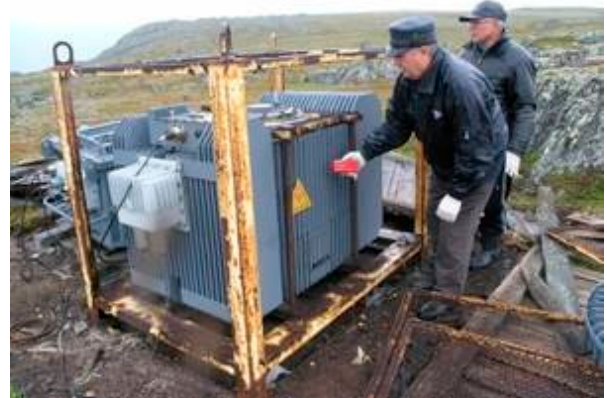
Figure 6. Radioisotope Thermoelectric Generator (RTG) used to supply power to lighthouses and navigation beacons [106].